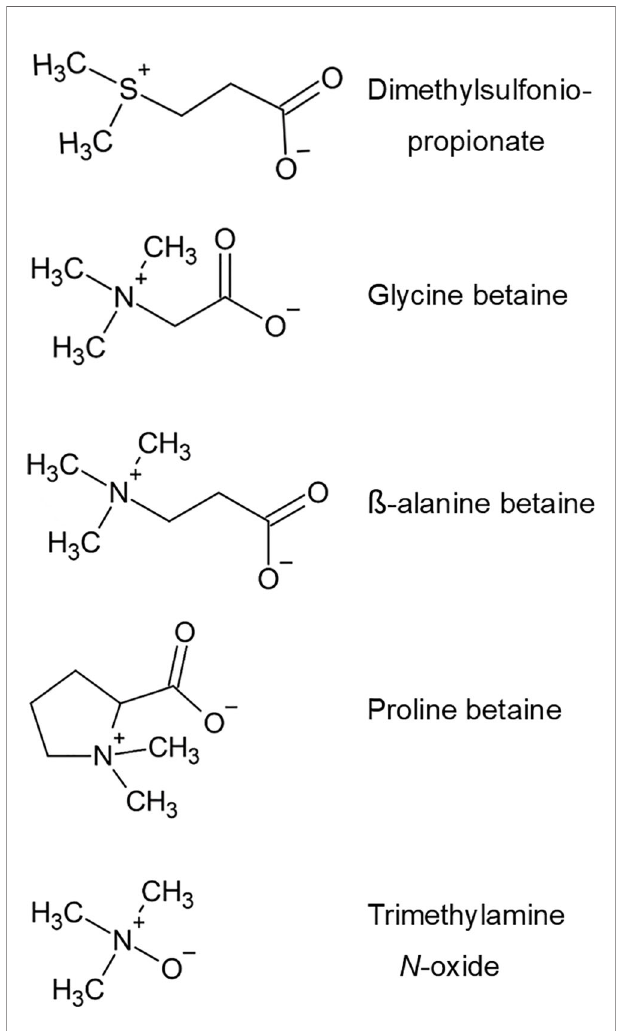
FIGURE 1 | Chemical structures of fi ve compounds that are discussed in this manuscript: dimethylsulfoniopropionate (DMSP), glycine betaine (often called simply “ betaine ” in the older literature); ß-alanine betaine (trimethylammonium propionate); proline betaine (stachydrine), and trimethylamine N -oxide